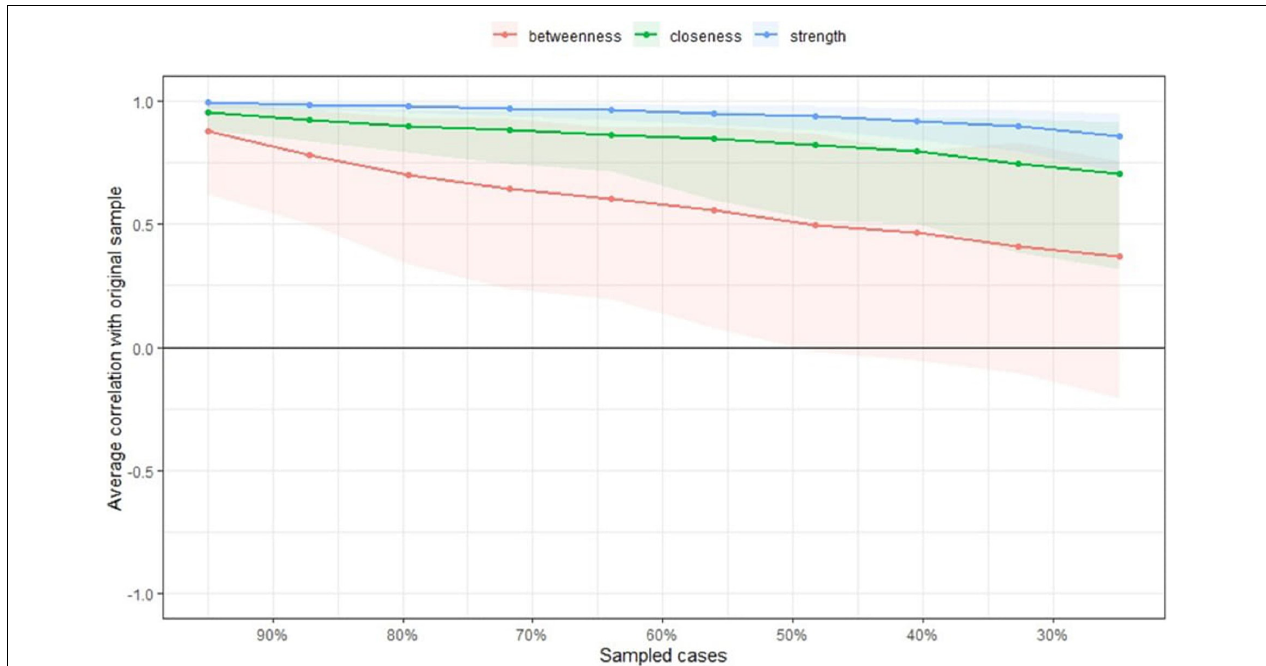
FIGURE 7 | Average correlations between the centrality indices of networks sampled with participants dropped and the original participants. Colored lines depict the means, and areas depict the range from the 2.5th quantile to the 97.5th